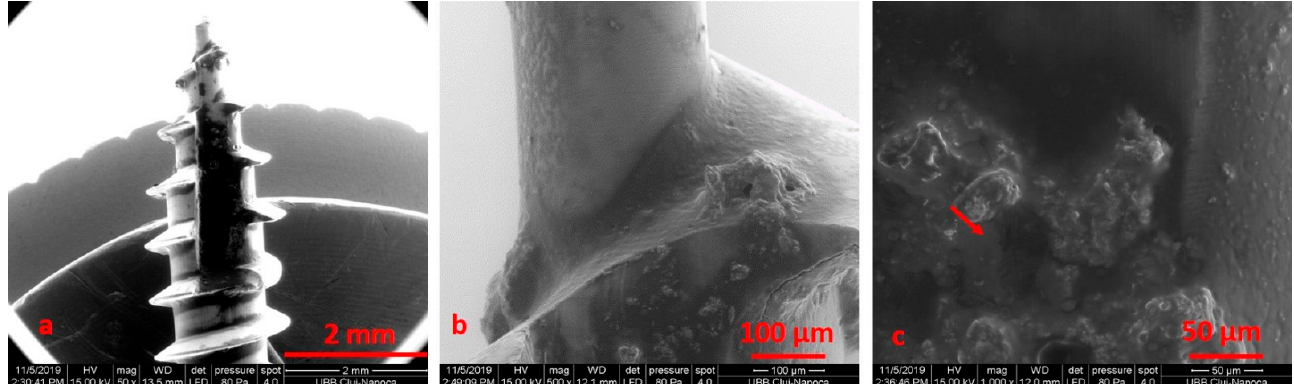
Figure 8. SEM images of non-sterilized mini-implants, recovered from patients, at ×50 ( a ), ×500 ( b ), ×1000 ( c ) magnifica- tion.